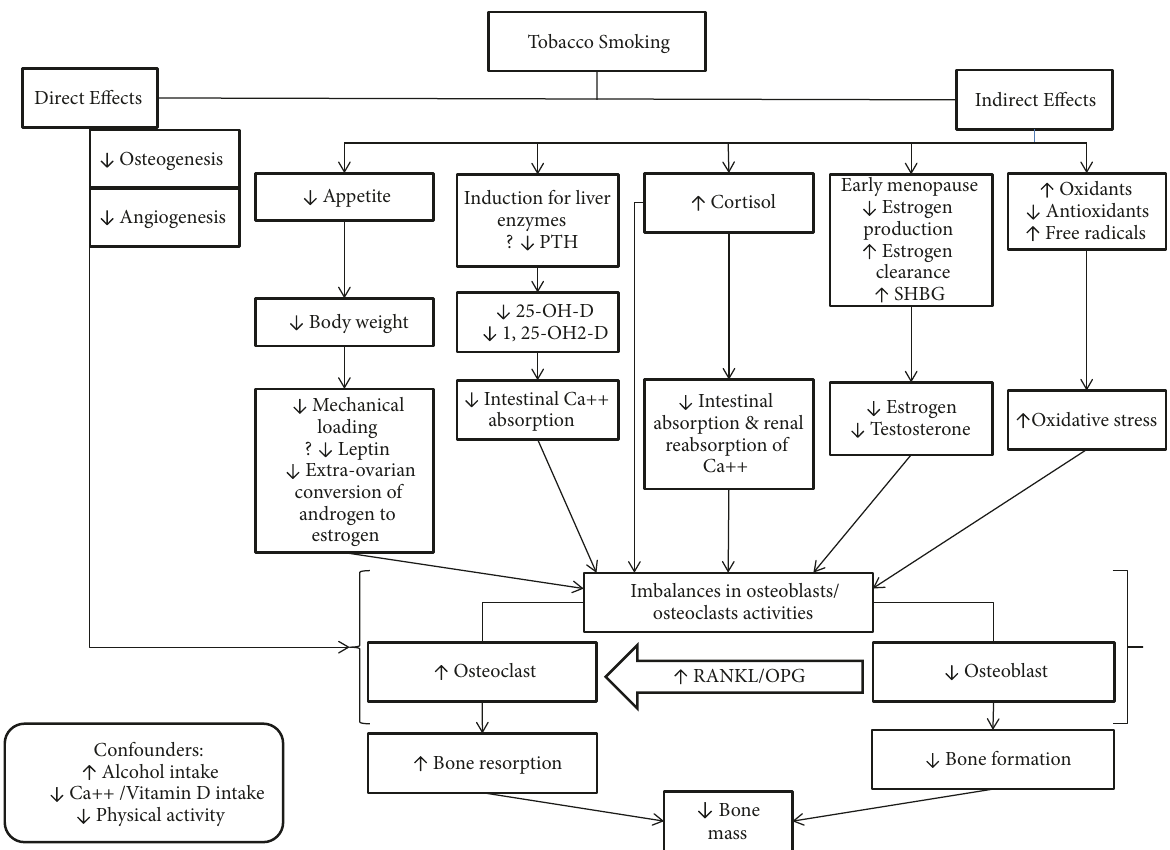
Figure 1: Potential pathophysiologic mechanisms of decreased bone mass in tobacco smokers. PTH: parathyroid hormone; 25-OH-D: 25-hydroxy vitamin D; 1, 25-OH2-D: 1, 25 dihydroxyvitamin D; RANKL: Receptor Activator of Nuclear Factor-Kappa B Ligand; OPG: